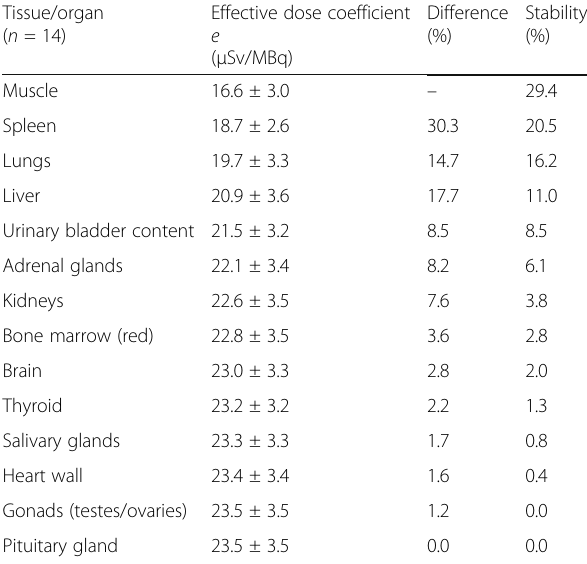
Table 3 Impact of number of tissues/organs for ICRP Publication 110 voxelized reference phantoms using ICRP Publication 103 tissue weighting factors, w T , to calculate the effective dose coefficient, e , with the SD. The difference in percent calculated according to Eq. 4 and stability according to Eq.